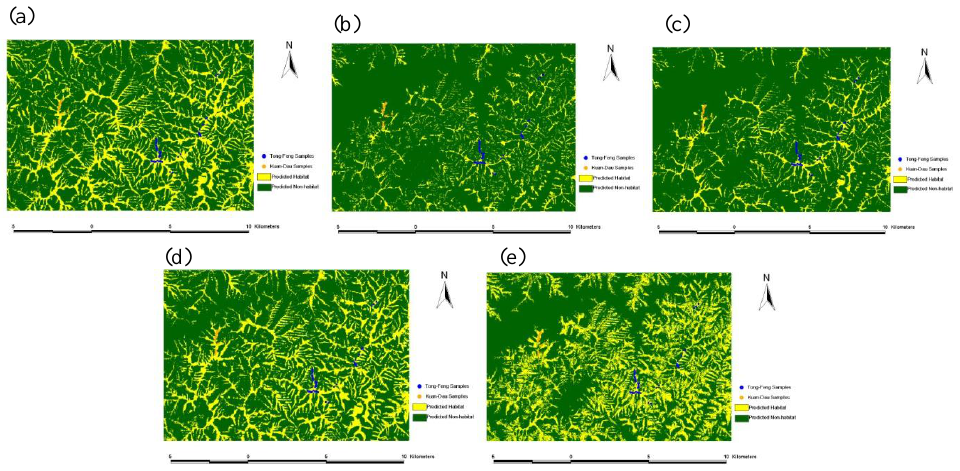
Figure 1. Location map of study area.